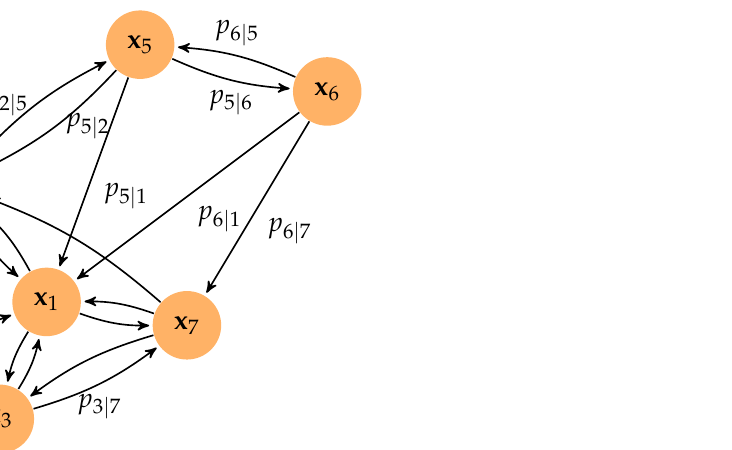
Figure A1. Five nearest neighbors of point x i for a particular set of points in R 3 , where, for simplicity, d j = d ( x i , x i